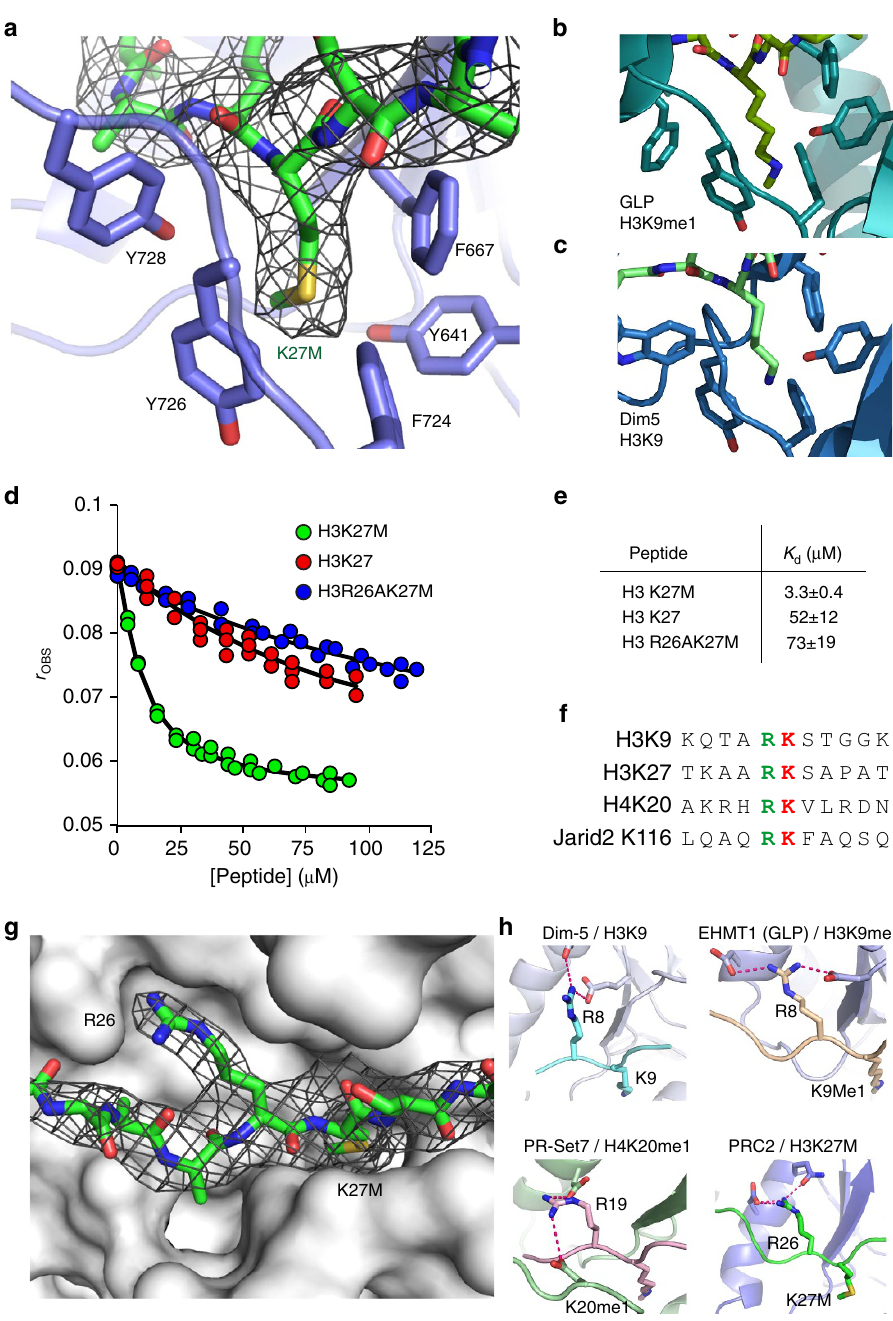
Figure 2 | Inhibition of PRC2 by H3K27M. ( a ) Stick representation of the EZH2 ‘lysine’ pocket (blue) with the Fourier Map covering the histone H3K27M side chain (green). An unbiased Fourier Map (Fo-Fc omit map contoured at 2 s ) covering the H3K27M peptide (green stick representation) is included. The peptide occupies the canonical substrate binding cleft of EZH2 and there is good density for the methionine side chain. ( b ) Equivalent view of the lysine binding channel in GLP/EHMT1–H3K9me1 (ref. 13) and ( c ) Dim5–H3K9 complexes 26 (lower panel). ( d ) Fluorescence anisotropy displacement titrations in which unlabelled peptides (H3K27M (green circles), H3K27 (red circles) and H3R26AK27M (blue circles)) were added to a mixture of FAM-H3K27M (0.4 m M) and PRC2 (4.3 m M) in the presence of SAM (320 m M). A full description of the binding experiment is provided in the ‘Methods’ section and in Supplementary Fig. 4 ( e ) Dissociation constants for peptide binding to PRC2. ( f ) Sequence flanking the methylated lysine (red) of repressive chromatin marks indicating the invariant arginine residue (green). ( g ) Surface representation of the substrate binding site in the EZH2 SET domain indicating the Arg( (cid:3) 1) binding pocket and showing the unbiased Fourier Map (Fo-Fc omit map contoured at 2 s ). ( h ) Equivalent views of repressive histone substrate binding in the structures of SET domains of PRC2, Dim-5, GLP/EHMT1 and PRSET7 highlighting the presence of related Arg ( (cid:3) 1)